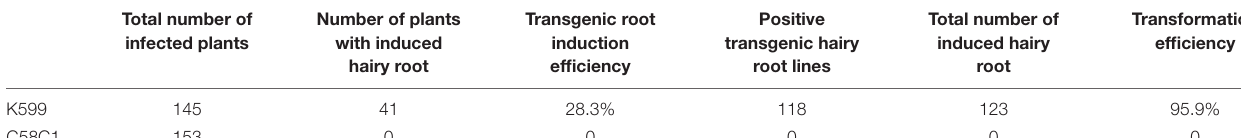
TABLE 1 | Transgenic hairy roots of Casuarina equisetifolia using dipping cut stem in bacterial suspension.